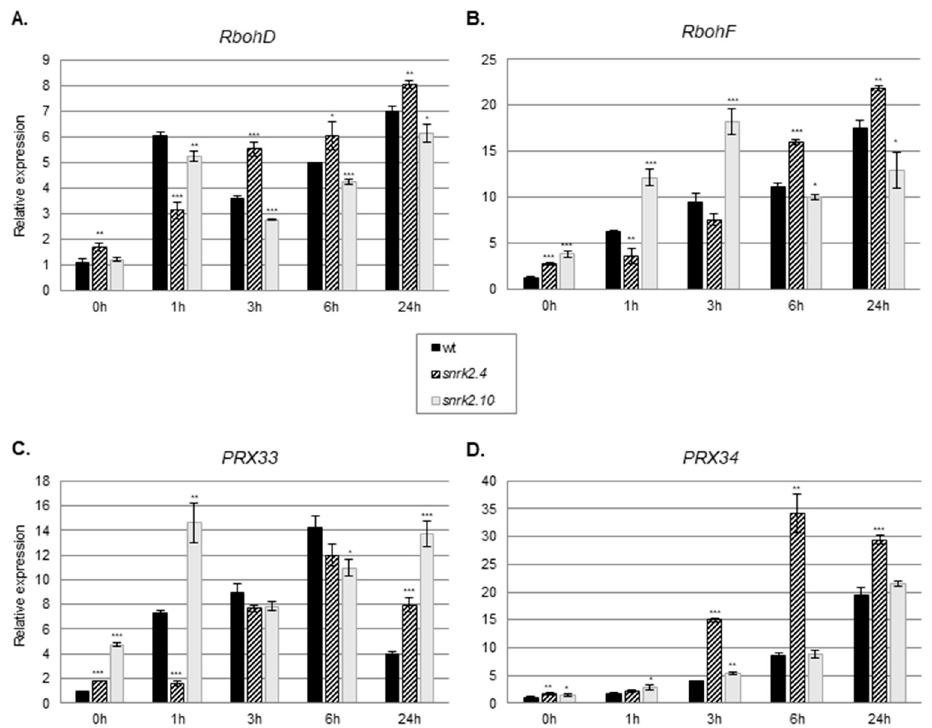
Figure 2. SnRK2.4 and SnRK2.10 affect the expression of genes involved in ROS homeostasis during response to salt stress. Expression (mRNA level) of ( A ). RbohD — respiratory burst oxidase homolog protein D ; ( B ) RbohF—respiratory burst oxidase homolog protein F ; ( C ) PRX33 — peroxidase 33 ; and ( D ) PRX34 — peroxidase 34 was determined by RT-qPCR in wt plants and snrk2 mutant lines subjected to treatment with 150 mM NaCl at times indicated (h); error bars represent SD; stars represent statistically significant differences in comparison with the wt plants (Student t -test) where * p < 0.05; ** p < 0.001; *** p < 0.0001. At least two independent biological replicates of the experiment were performed. Results of one representative experiment are shown.